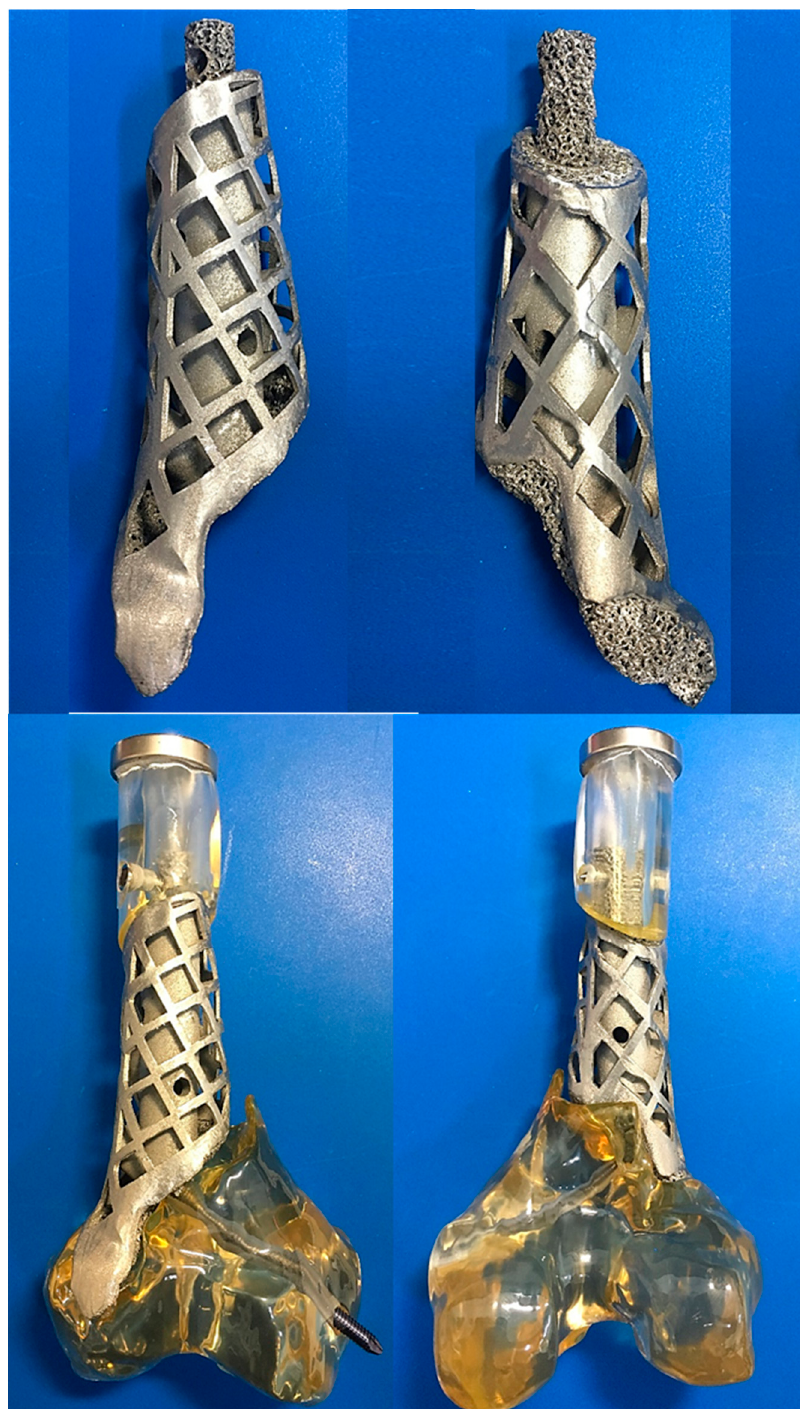
Figure 8. The novel patient specific 3DP titanium implant. Note the central solid cylinder and the outer lattice structure of the implant body, with protected spaces for the morselized bone graft. The perfectly fit bone-implant interface of the implant consists of the proximal shell with a stem and the distal shell, both with unique porous structures facilitating osteointegration.